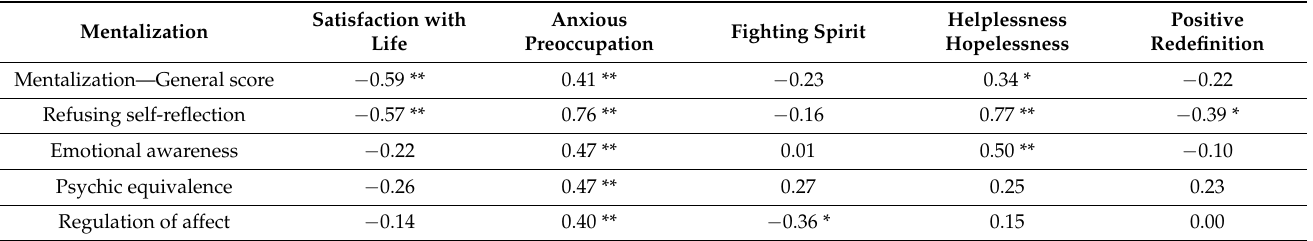
Table 3. Coefficients of correlation between satisfaction with life, mental adjustment, and